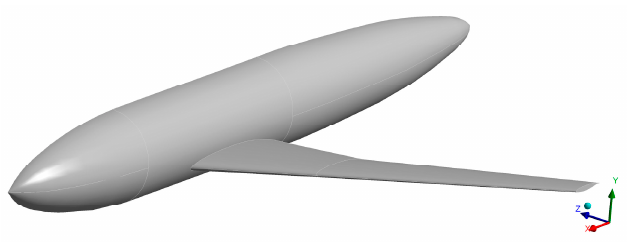
Figure 2. DLR-F4 initial CAD model without winglets.